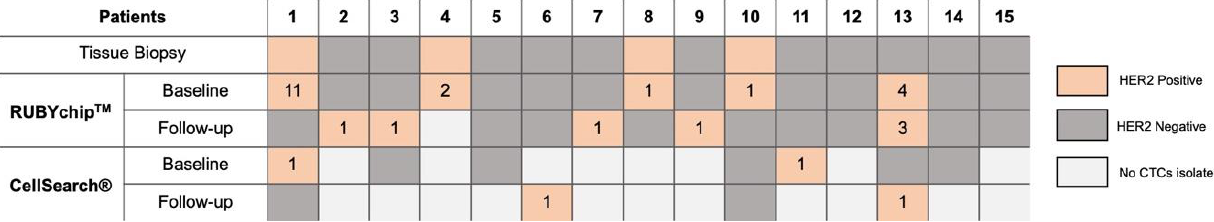
Figure 6. Representative scheme on the HER2 expression status on the primary tumour by tissue biopsy and on the CTCs at two different collection time-points, baseline (before starting systemic therapy) and follow-up (after 12 weeks of systemic treatment), by both technologies, RUBYchip™ and CellSearch ® . The HER2+ CTC events are represented in orange, HER2− CTC in grey, and in white no CTCs were isolated. The number of HER2+ CTCs is represented at the respective collection moment, for each technology.